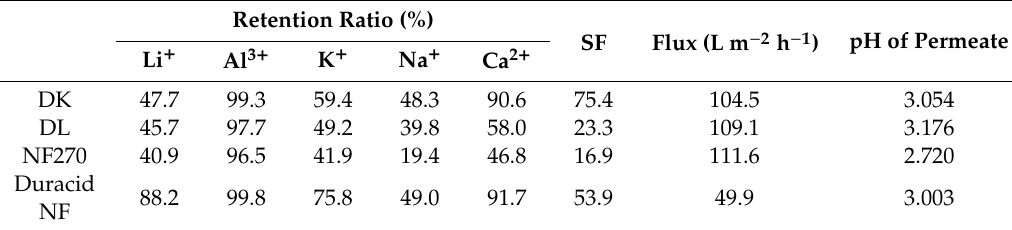
Table 11. Retention ratio of Li + , Al 3+ , K + , Na + , and Ca 2+ ; SF; flux and permeate pH of four NF membranes.